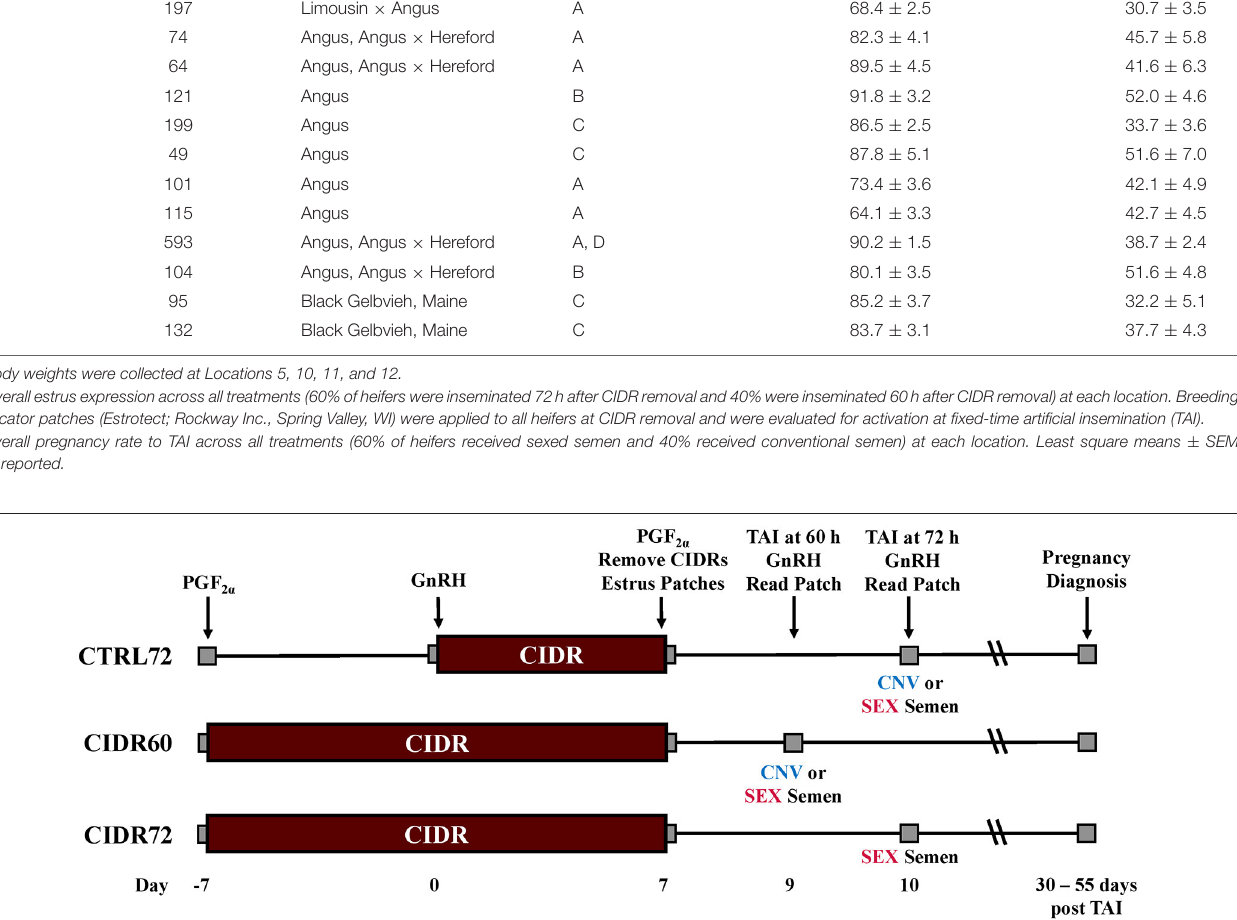
FIGURE 1 | Schematic of treatments. GnRH, gonadotropin-releasing hormone; PGF, prostaglandin F 2 α ; CIDR, controlled internal drug releasing insert (progesterone). CTRL72, PG-7 7-d CO-Synch + CIDR protocol; CIDR60, same as CTRL72 but CIDR inserted on Day − 7 and TAI performed 60h after CIDR removal; CIDR72, same as CIDR60 but TAI delayed to 72h after CIDR removal; CNV, conventional semen used for TAI; and SEX, sexed semen used for TAI. Estrus patches = Breeding indicator patches (Estrotect; Rockway Inc., Spring Valley, WI) were applied to all heifers at CIDR removal and were evaluated for activation at their respective time